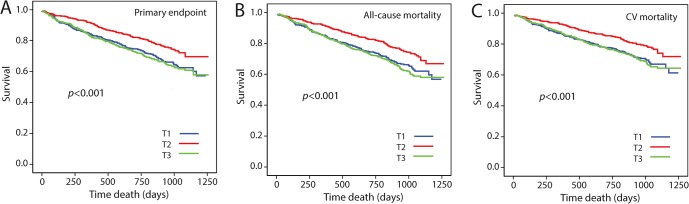
Kaplan-Meier curves for the primary end point (panel A), as well as for all-cause (B) and CV (C) mortality according to tertile sFRP3 concentration.T1, lowest tertile serum sFRP3; T3, highest tertile serum sFRP3. Patients with T2 sFRP3 showed a markedly better outcome than patients in T1 and T2; p<0.001 for the primary end point and all-cause mortality, p<0.002 for CV mortality.